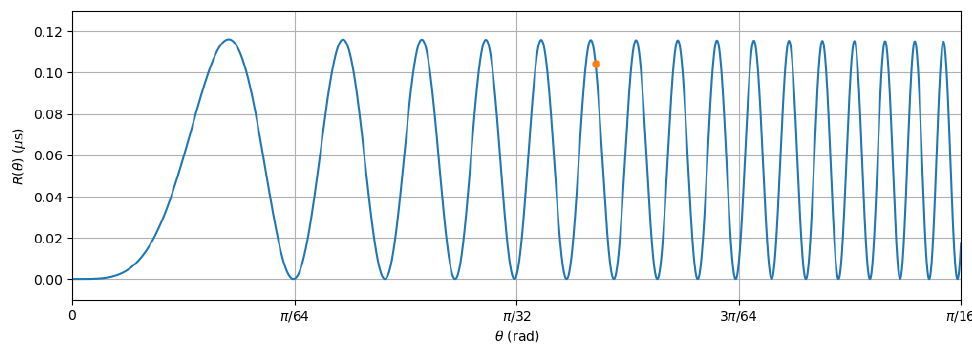
Figure 4. Zoomed plot of the R ( θ ) function relative to the SMBHB candidate PKS 2131–021 and the MSP J2145–0750. The horizontal axis indicates the values assumed by the θ variable, expressed in ra- dians. The vertical axis indicates the values assumed by the R ( θ ) function, expressed in nanoseconds. The orange dot indicates the value assumed by R ( θ ) when θ coincides with the actual angle between the SMBHB candidate PKS 2131–021 and the MSP J2145–0750, which is θ = 0.1156.